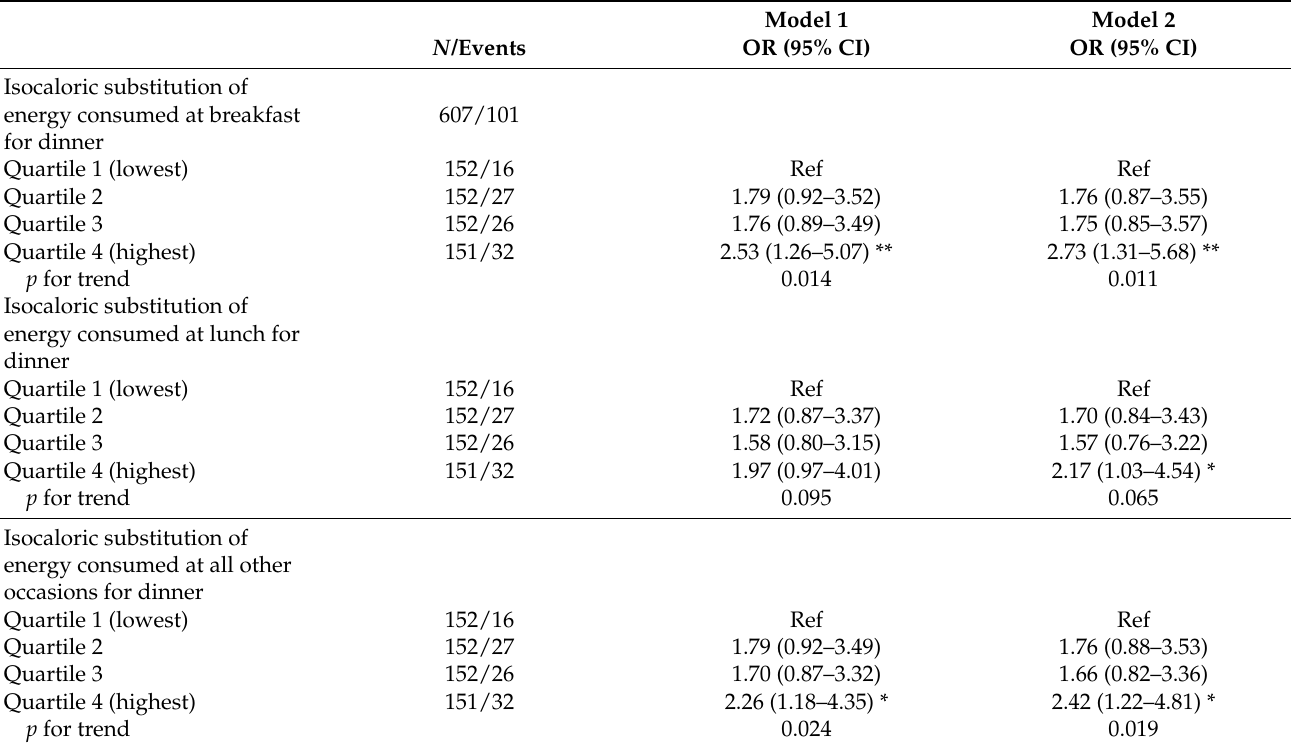
Table 4. Odds ratios (95% confidence interval) for incident metabolic syndrome among participants in the Seniors-ENRICA-1 cohort study (2008/10 to 2015) when isocaloric substitution of breakfast, lunch, or all other occasions of energy intake for energy intake at dinner. N = 607.